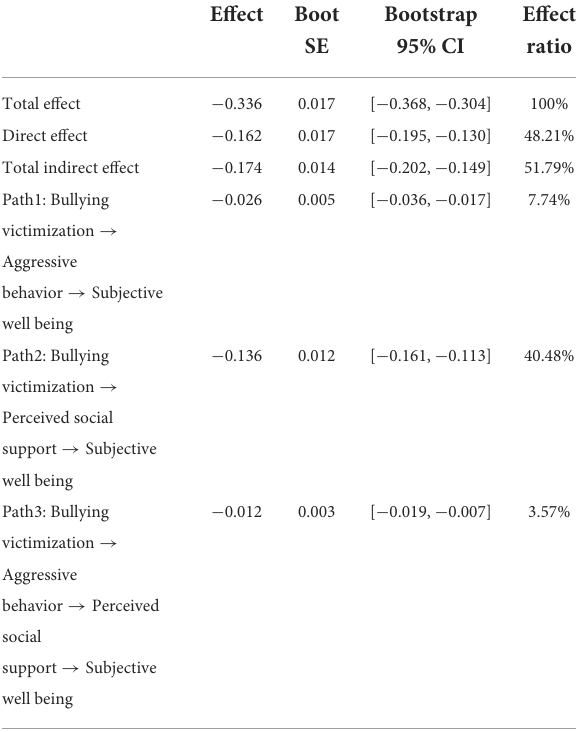
TABLE 6 Mediating effect analysis of bullying victimization and subjective well